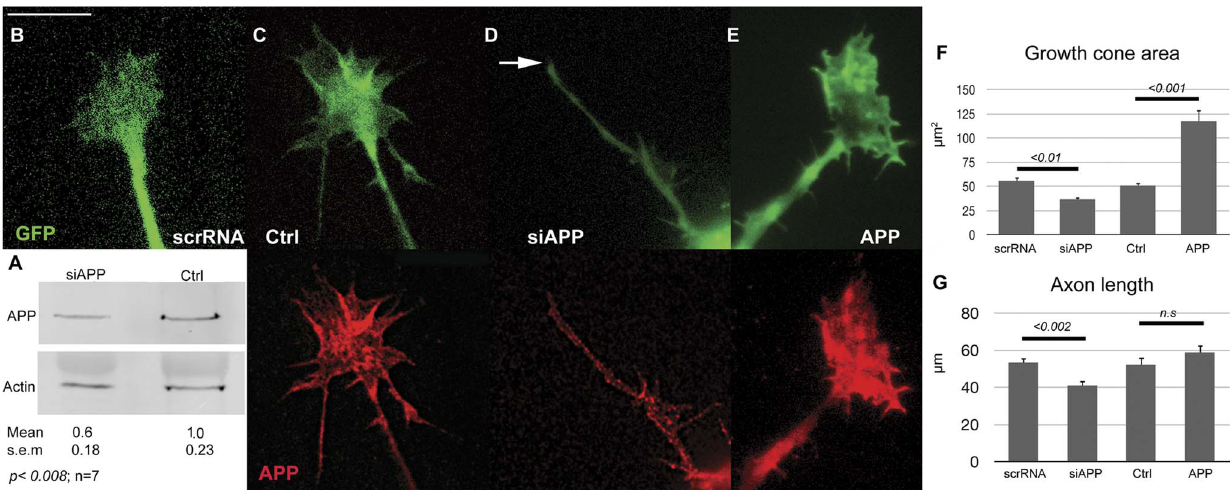
Figure 2. APP misexpression in wt mouse neurons on laminin. A. Western blot of hippocampal cultures treated with APP-targeted siRNA (siAPP) versus control siRNA. siAPP reduces the total APP level significantly (densitometric analysis: arbitrary values normalized to control; actin, loading control). B–E. Fluorescence images of neurons (24 h in vitro ) transfected with GFP vector plus (left to right): scrambled siRNA (scrRNA), vehicle (Ctrl), siAPP, or APP vector, respectively. Top row, GFP fluorescence; bottom row, APP fluorescence. Arrow, fusiform GC. Scale bar 10 m m. F, G. GC area and axon length (means 6 s.e.) in transfected neurons at 24 h in vitro . Horizontal bars, p values in two-sample t tests. n.s., not significant.